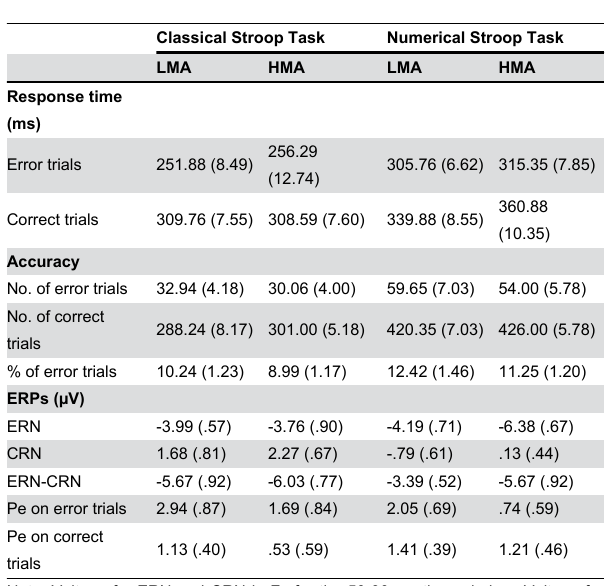
Table 2. Means (of medians) and standard errors (in brackets) for behavioral and ERP